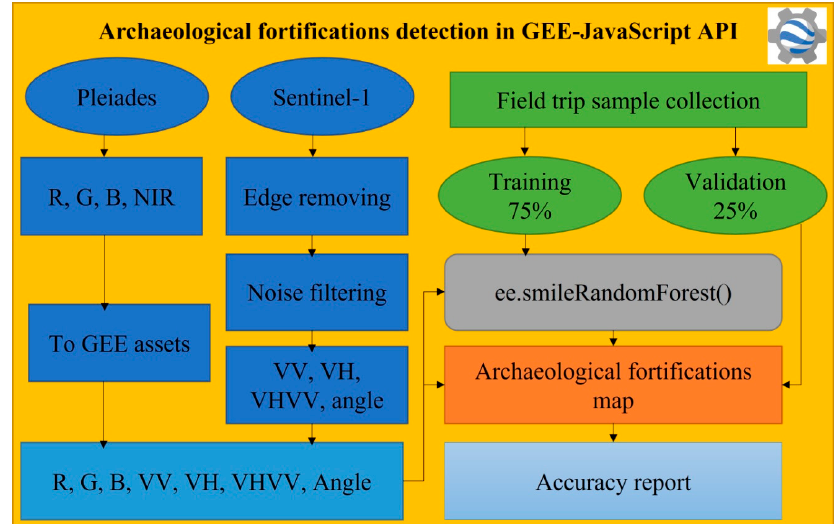
Figure 2. Framework approach.